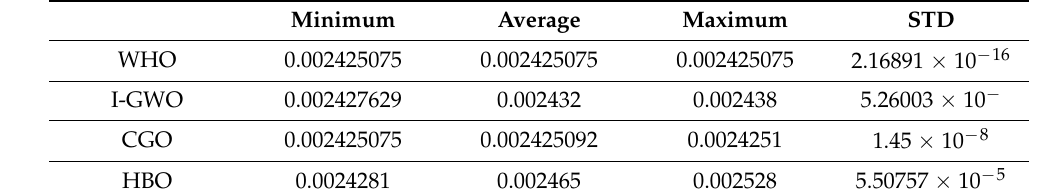
Figure 18. The convergence curve of all algorithms.